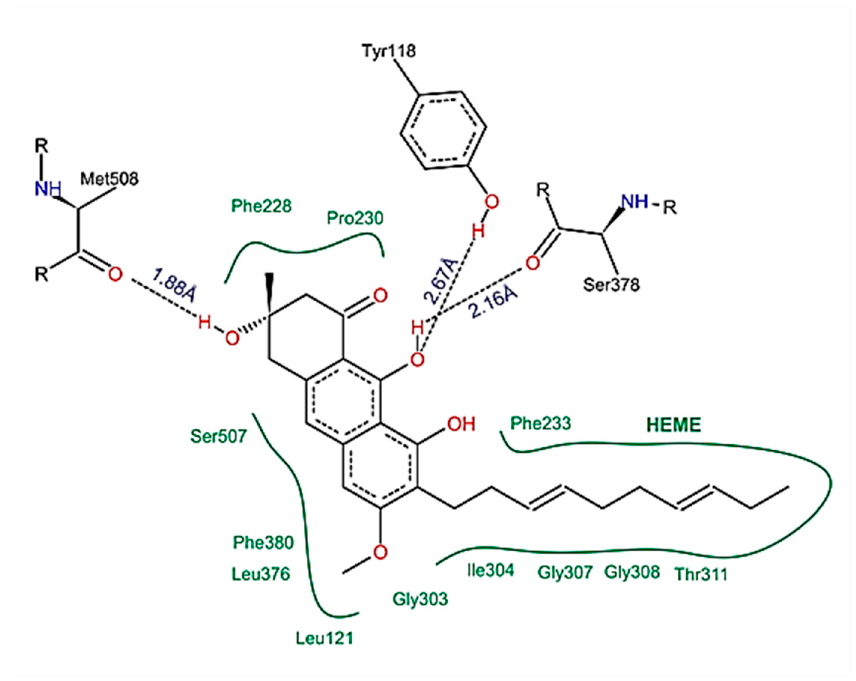
Figure 11. Schematic representation of the interactions between vismione D and CaCYP51, identified by molecular docking. It is possible to observe the formation of hydrogen bonds and hydrophobic contacts between the ligand and the enzyme residues, including interactions with the heme group. The figure was obtained with